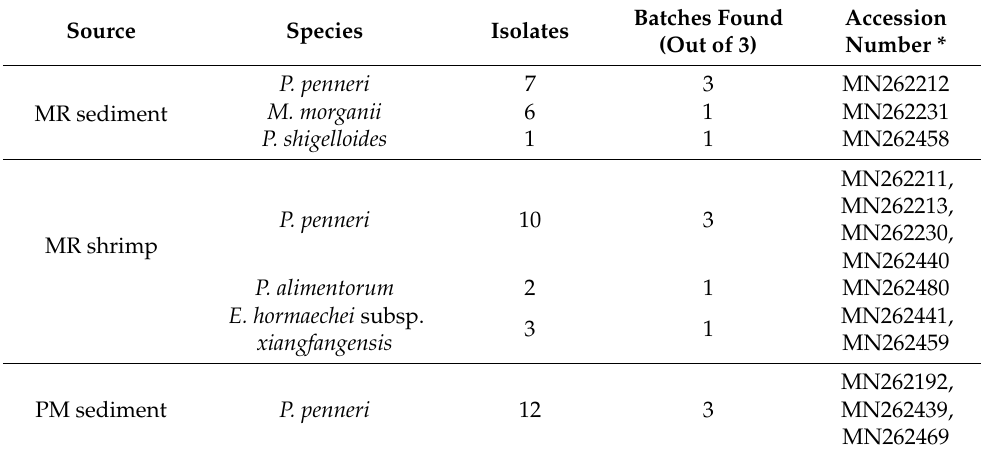
Table 3. Number and source of species isolated from farm sediment and